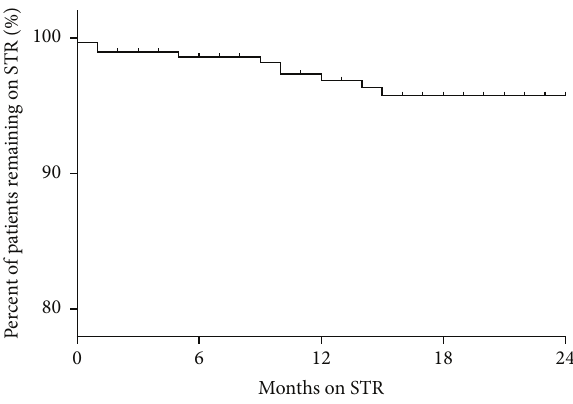
Figure 1: Durability of STRs over 24 months (𝑛 = 299)